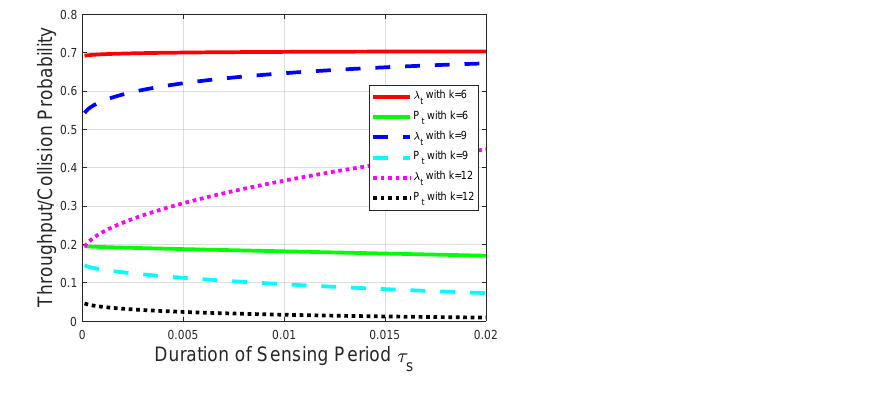
Figure 8. Throughput and collision performances of the CRN with a given transmission period when τ s tends to